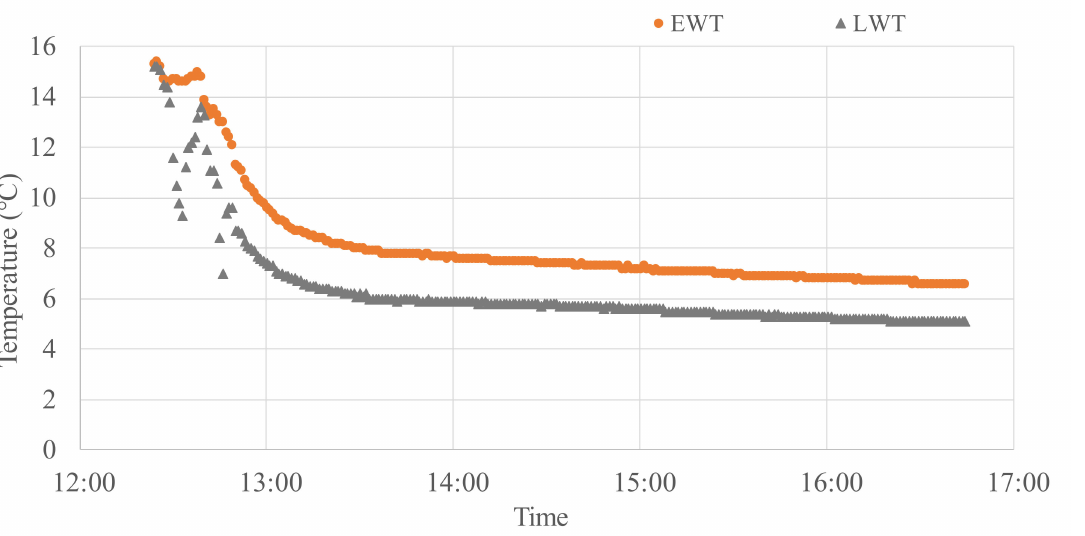
Figure 10. Fluctuation of EWT and LWT in Case 2.